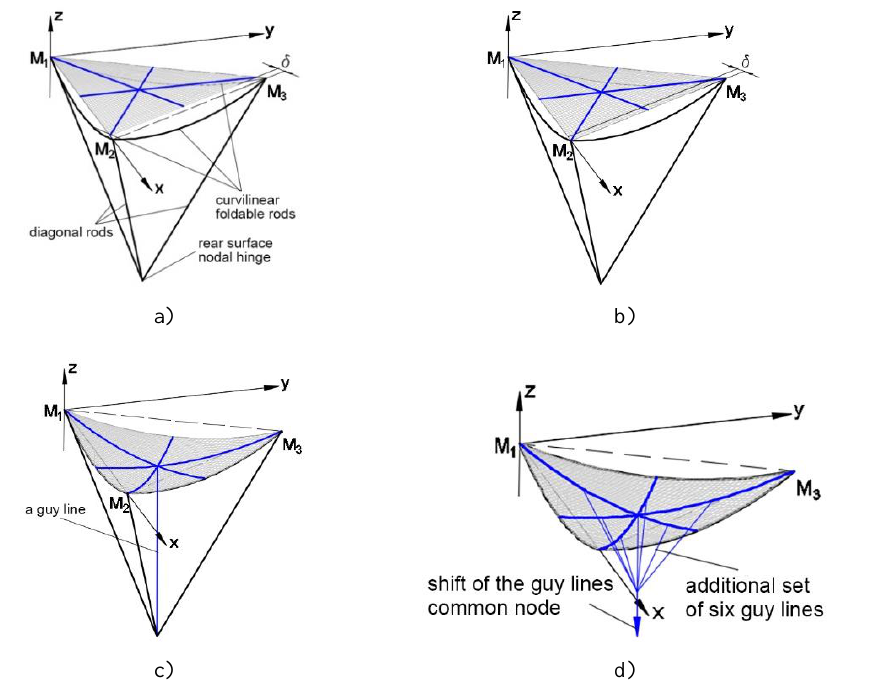
Fig. 19. SGS consisting of three cables and additional guy lines.